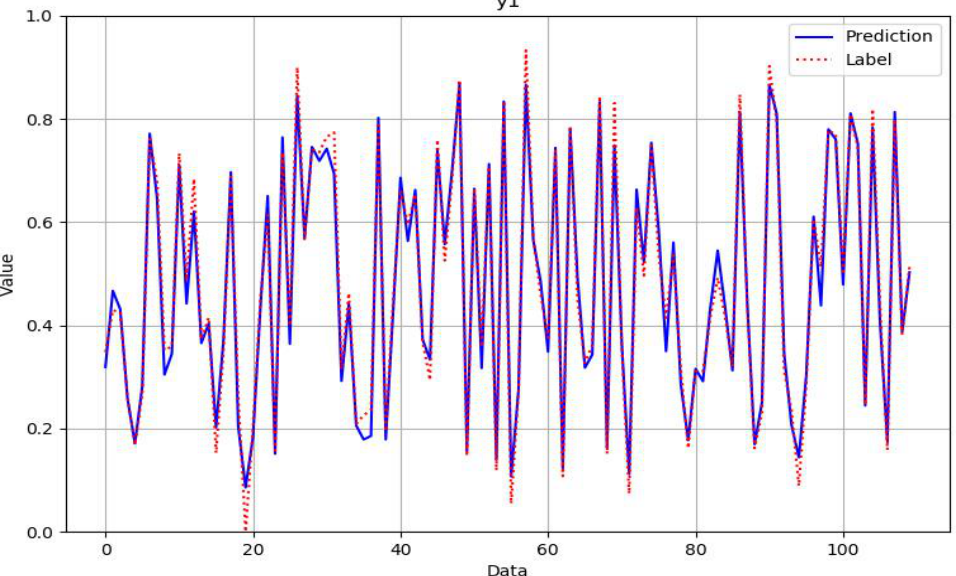
Figure 12. Comparison of predicted and actual values in the fineness verification data set after nor- malization.